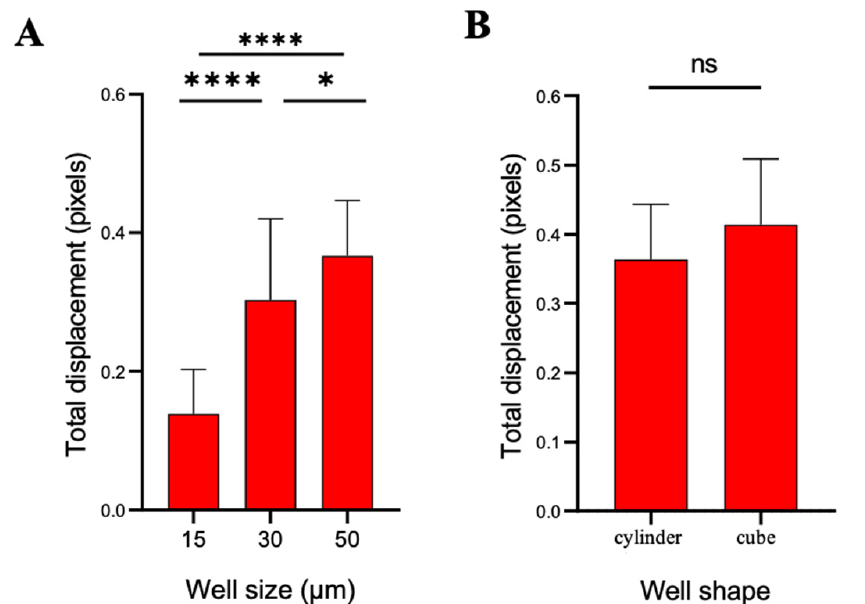
Figure 3. ( A ) Comparison of nanomotion signal between 3 different diameters of cylindrical mi crowells (15 µ m, 30 µ m and 50 µ m) (n = 26). ( B ) Comparison of nanomotion signal between cylindrical (50 × 50 µ m) and rectangular (50 × 50 × 50 µ m) microwells (n = 26). Wilcoxon test: **** p < 0.0001; * p < 0.1; ns: not signi fi cant.